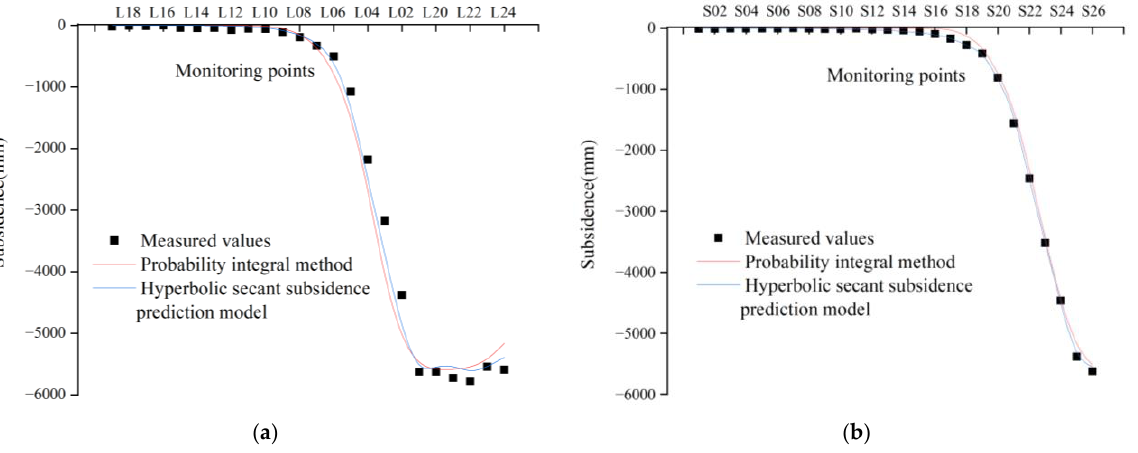
Figure 13. Comparison of predicted values of different models. ( a ) Predicted values of L-line. ( b ) Predicted values of S-line.